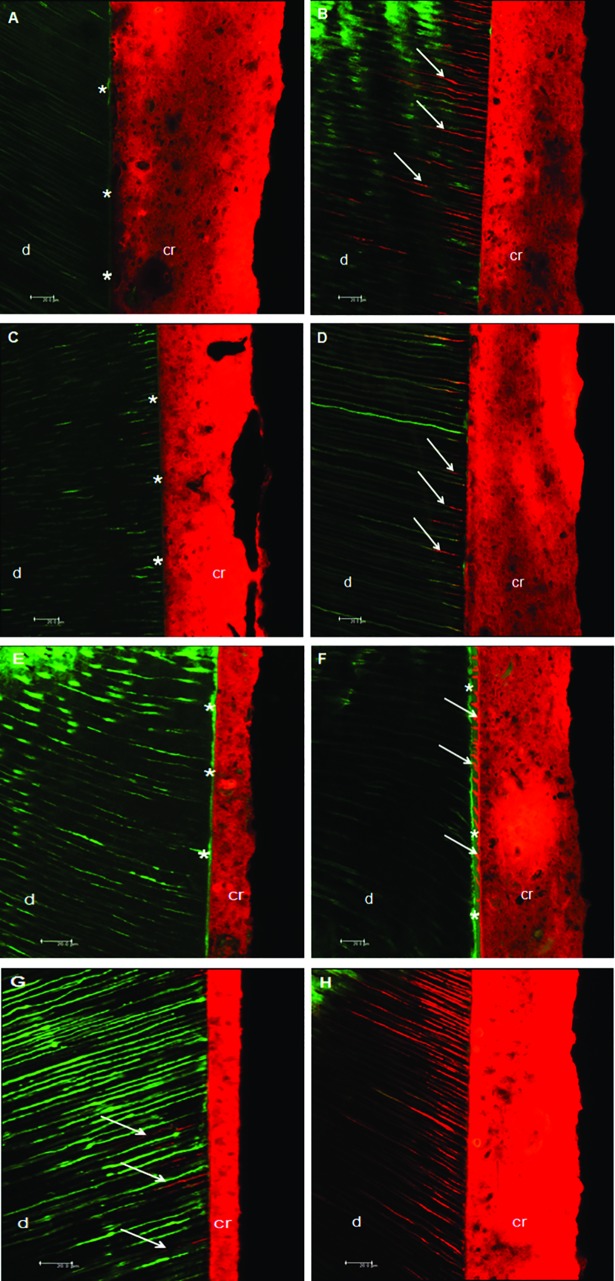
Analysis in confocal microscopy of sound and eroded dentin submitted to different surface treatments.(A) Control group–sound dentin. It is possible to observe a continuous interface, without cracks (asterisks) and without the formation of tags. (B) Control group–eroded dentin. Adhesive interface without hydrid layer formation, however, an intense formation of resin tags (arrows) was observed in relation to the sound dentin. (C) 2% Chlorhexidine group–sound dentin. Note the absence of cracks in the adhesive interface as well as hybrid layer formation (asterisks). (D) 2% Chlorhexidine group–eroded dentin. Absence of cracks in the adhesive interface, with formation of some visible tags (arrows). (E) 20% Polyacrylic acid group–sound dentin. Pronounced hybrid layer formation throughout the adhesive interface (asterisks). (F) 20% Polyacrylic acid group–eroded dentin. Hybrid layer formation throughout the adhesive interface, with increased thickness compared to sound dentin (asterisks) and tag formation ≤ 3 μm in almost all interface (arrows). (G) 0.1 M EDTA group–sound dentin. Regarding the quality of the adhesive interface, it is possible to note the absence of cracks, with the formation of some resin tags measuring from 9 to 15 μm (arrows). (H) 0.1 M EDTA group–eroded dentin. Absence of cracks in the adhesive interface, without hybrid layer, but with the very dense formation of resin tags as well as in depth. *d = dentin / *rc = resin cement. Asterisks: hybrid layer formation; arrows: resin tags formation.